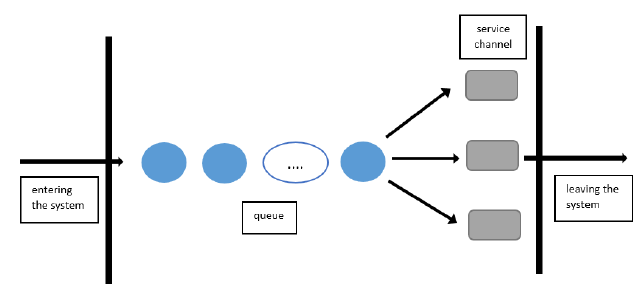
Figure 1. Graphical representation of queueing systems [14].